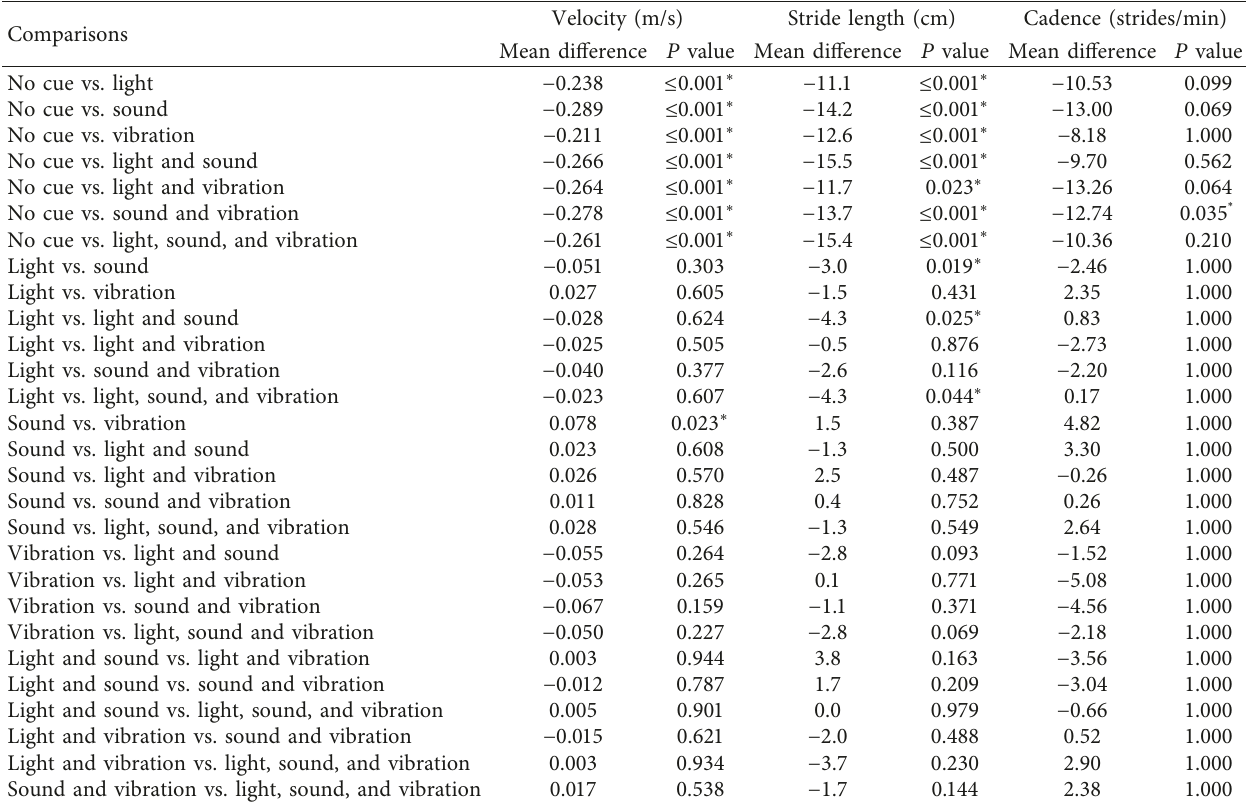
Table 2: Pairwise comparisons of all conditions.